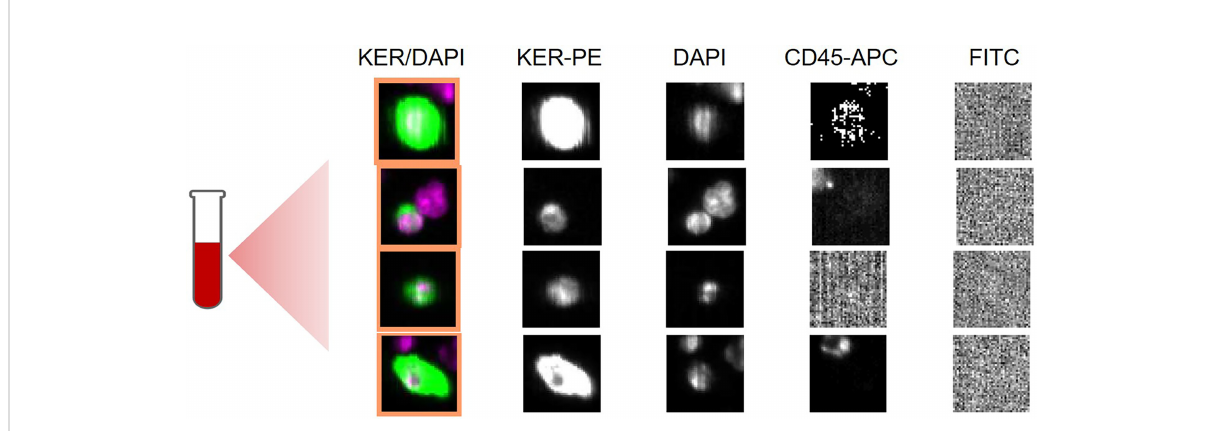
FIGURE 1 Selected CellSearch images showing circulating tumor cells (CTCs) in an exemplary patient of the training cohort. Blood specimen had been obtained from a 72- year old patient with metastatic iCCA, who received palliative chemotherapy. Each row shows a CTC detected in sample of 7,5 ml of whole blood. Nucleated cells (DAPI positive) that are positive for keratin (KER) and negative for CD45 with a diameter of at least 4 µm are called CTCs. KER/DAPI represent composite images. PE: phycoerythrin; APC: allophycocyanine, FITC: Fluorescein isothiocyanate, DAPI: (4 ′